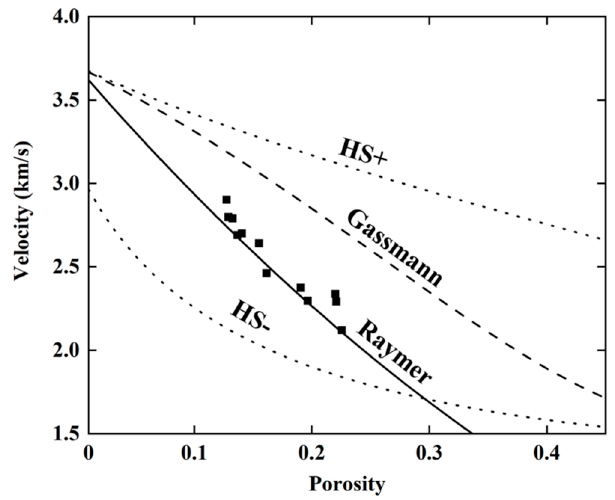
Figure 14. Different P ‐ wave velocity ‐ to ‐ porosity models. Figure 14. Di ff erent P-wave velocity-to-porosity models.